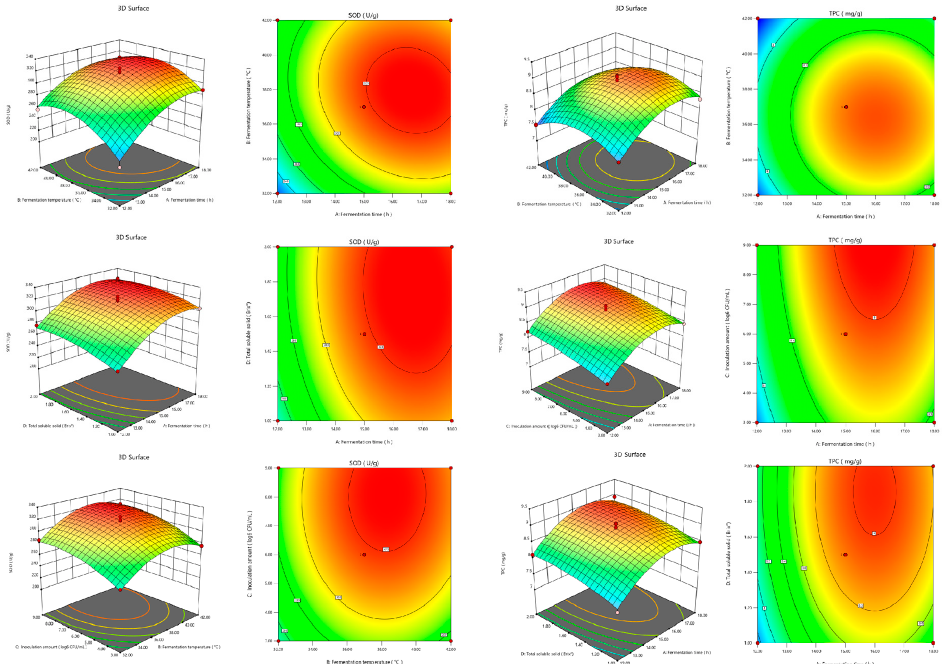
Figure 2. Effects of interaction of various factors on SOD activity and total phenolic concentration of FBMJ.